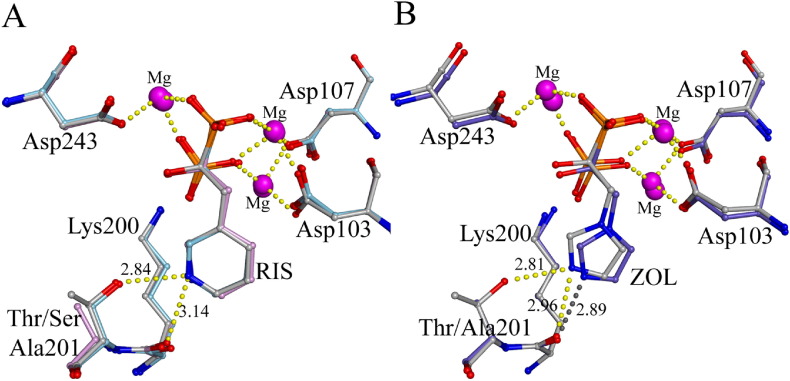
Structures of Thr201 mutants with N-BPs. A) Overlay of WT + RIS (grey, 1YV5), T201S + RIS (light blue, 2QIS) and T201A + RIS (plum, 4Q23). H-bonds are shown as yellow dashed lines and distances (Å) are given for RIS in the T201S structure. B) T201A + ZOL (purple, 4KFA) superimposed onto WT + ZOL + IPP (grey, 1ZW5). H-bond distances (Å) for the ZOL nitrogen are shown in yellow for wtFPPS and grey for T201A.